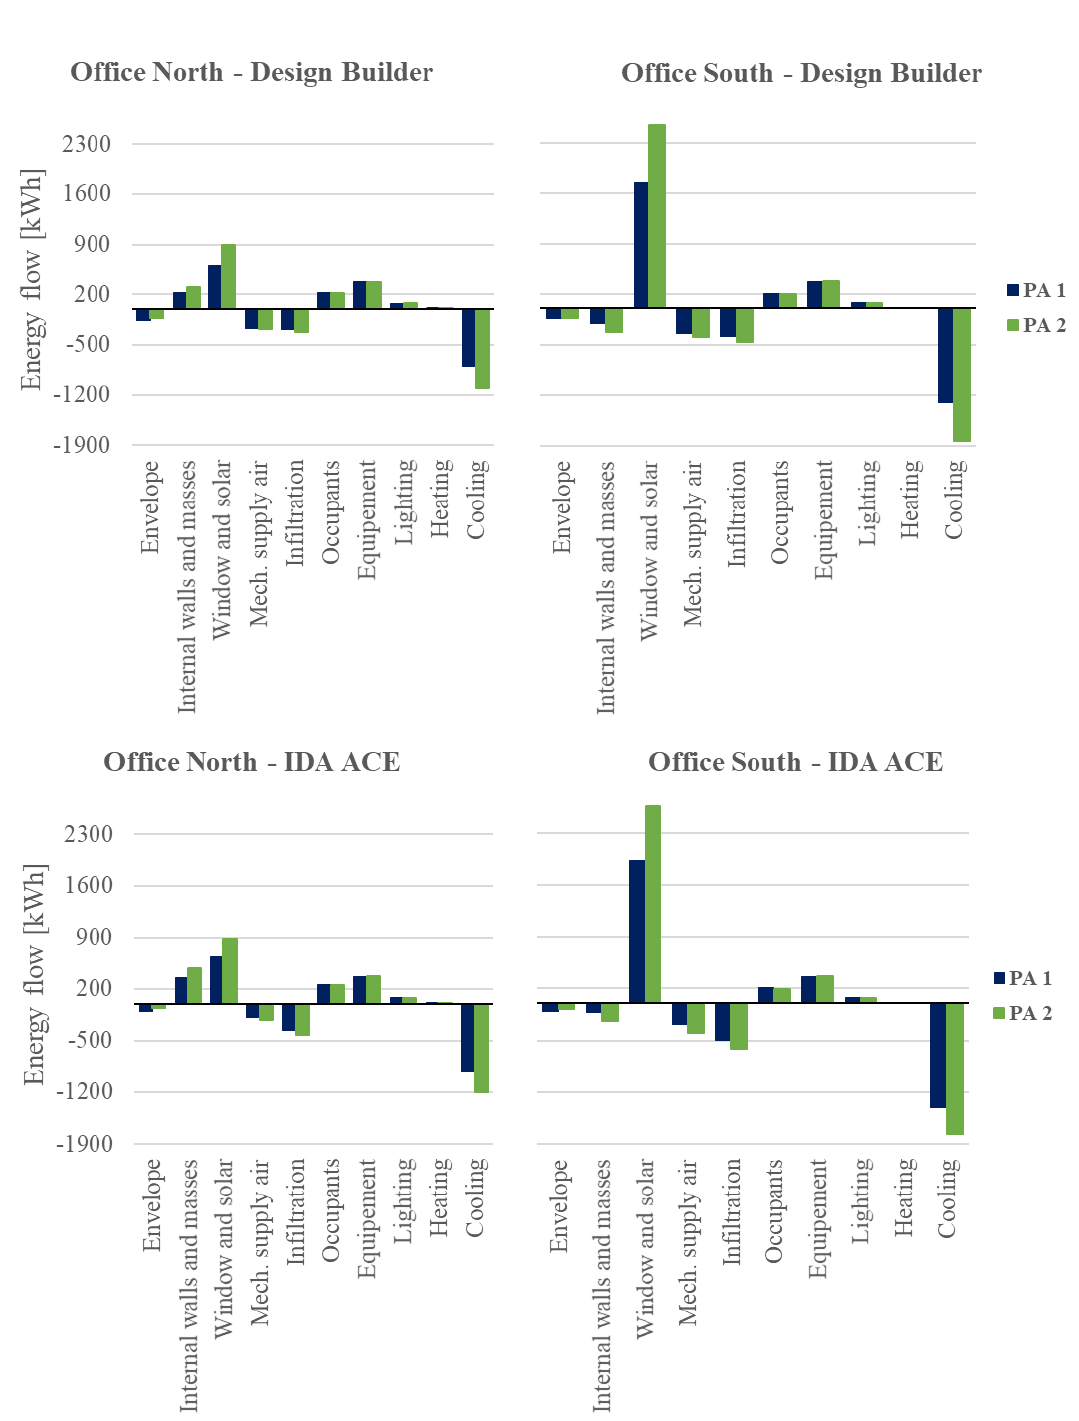
Figure 5. Energy flows for Palermo in Design Builder (up) and IDA ICE (down). PA 1: Palermo/scenario 1, PA 2: Palermo/scenario 2.